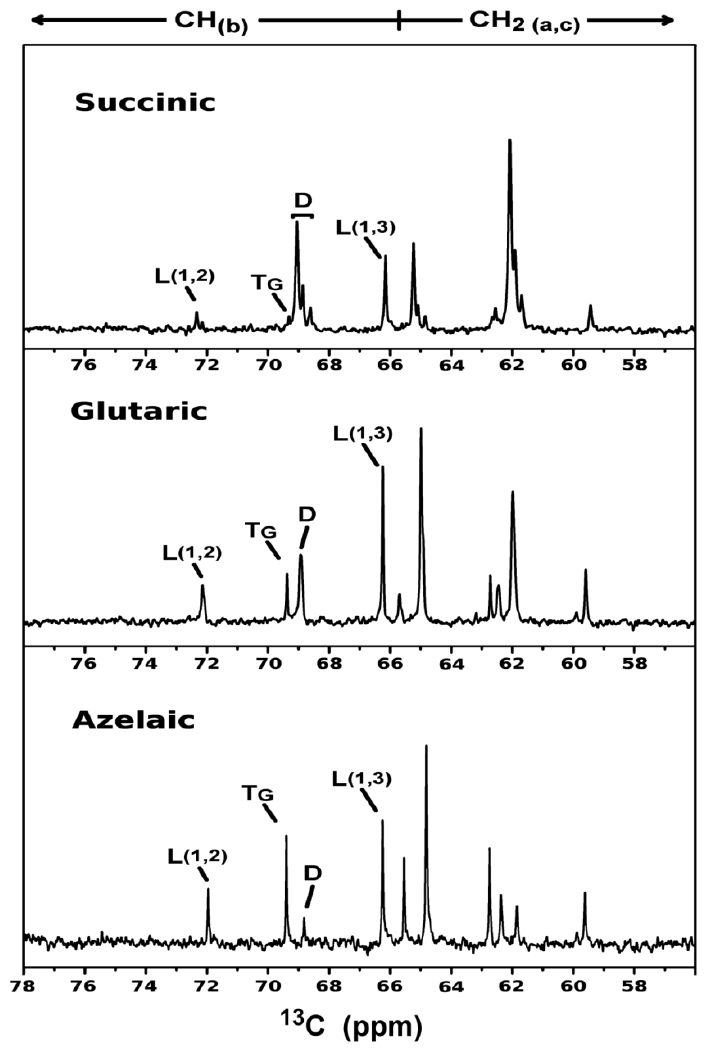
Figure 3. The glycerol region of representative, inverse-gated 13 C NMR spectra of the indicated diacids copolymerized with